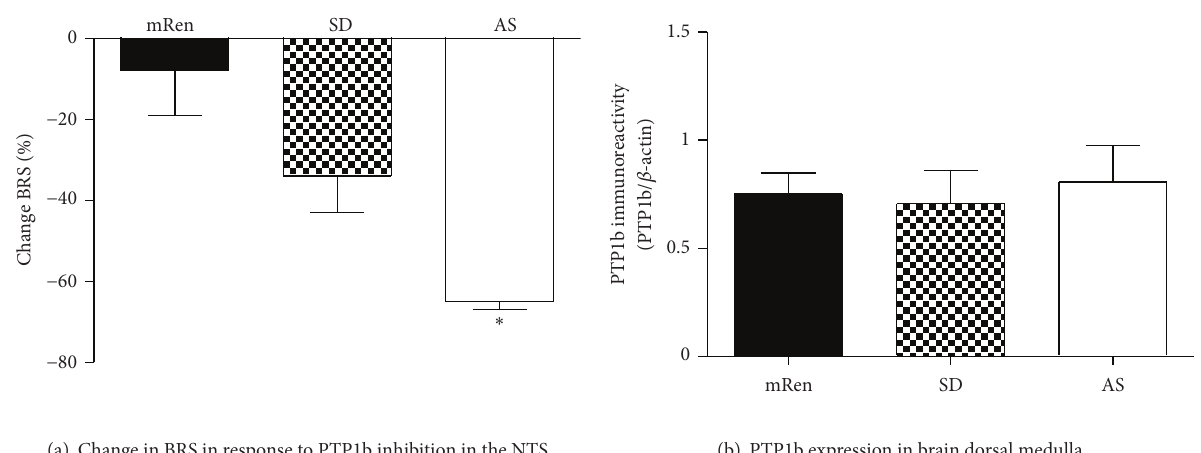
(b) PTP1b expression in brain dorsal medulla F 3: ASrAOGEN (AS) rats show signi�cantly greater reduction in the evoked BRS for control of HR following inhibition of PTP1b (a), despite similar levels of the PTP1b protein in dorsal medulla of the three strains (b). Mean –6 per group for solitary tract nucleus (NTS) microinjections, versus (mRen2)27 rats. Data replotted from [23] for the Sprague- Dawley (SD) rats and original data presented for ASrAOGEN and (mRen2)27 [mRen] rats. Western blotting carried out as published for SD rats [23] and original data presented for ASrAOGEN and (mRen2)27 rats. Note the PTP1b antibody recognizes both phosphorylated and nonphosphorylated forms.